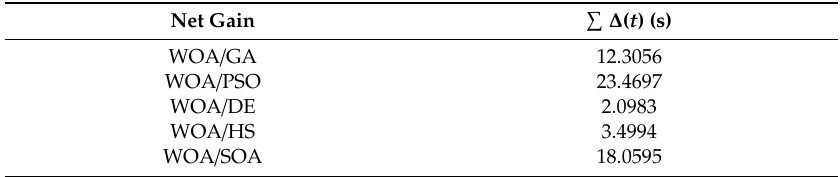
Table 19. Comparison of total net gain in time achieved by the WOA with the methods used in the literature for the IEEE 30-bus system.